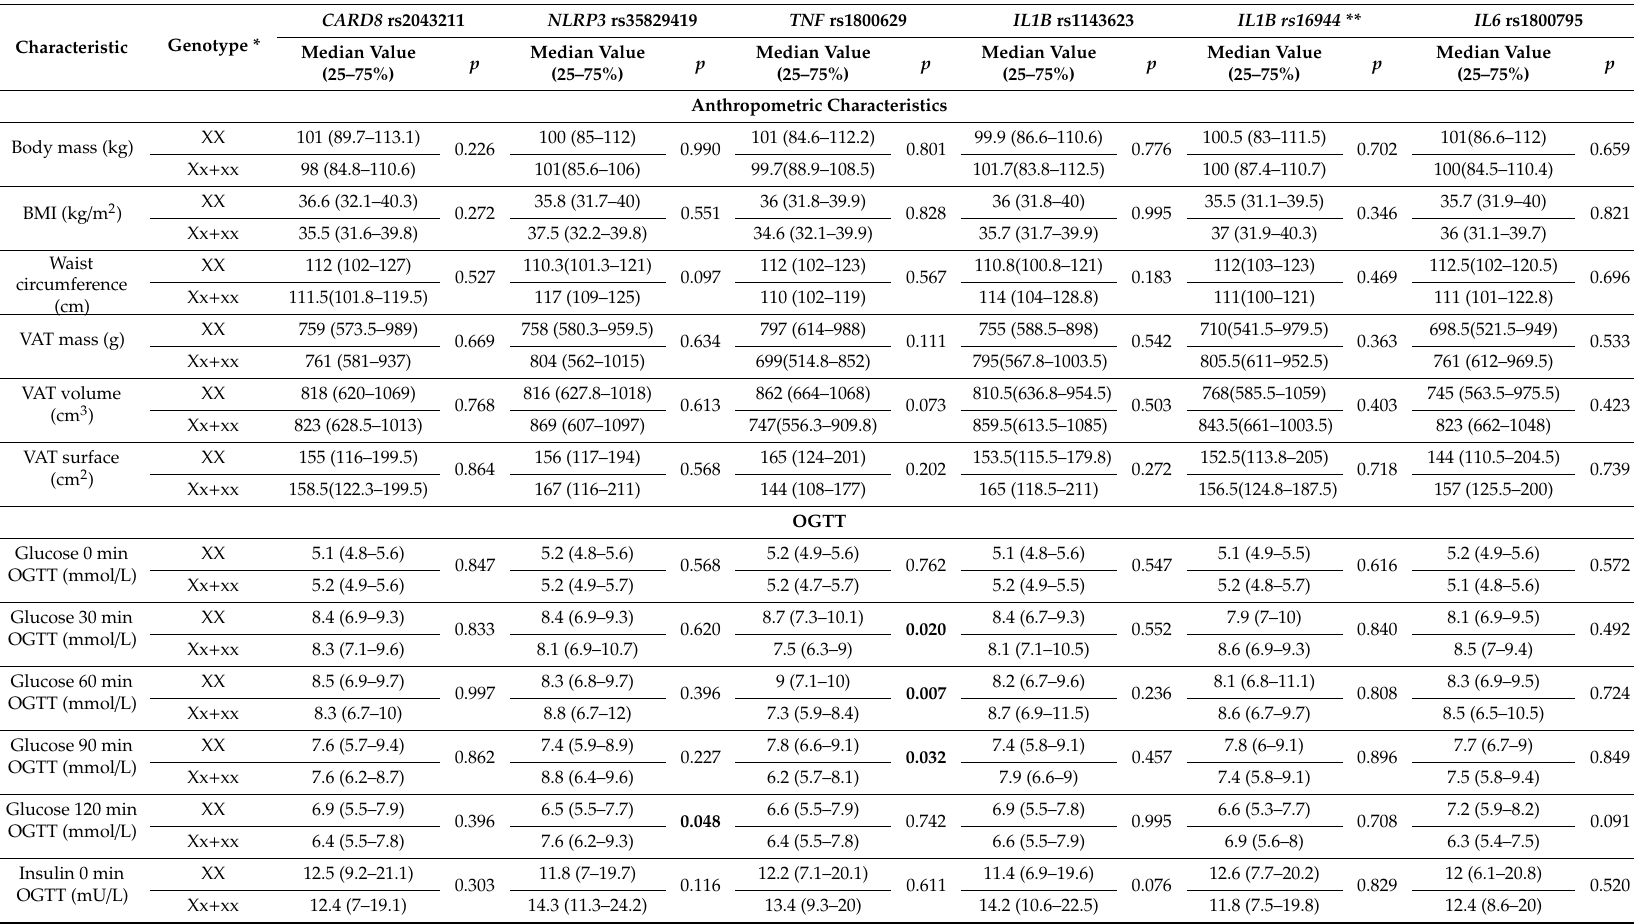
Table 5. E ff ects of polymorphisms in genes related to inflammation on PCOS patients’ clinical